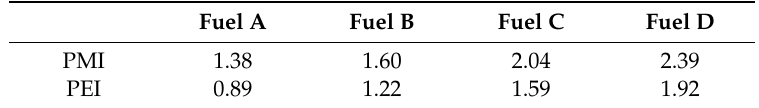
Table 3. Particulate matter index (PMI) and particulate evaluation index (PEI) values from the sample